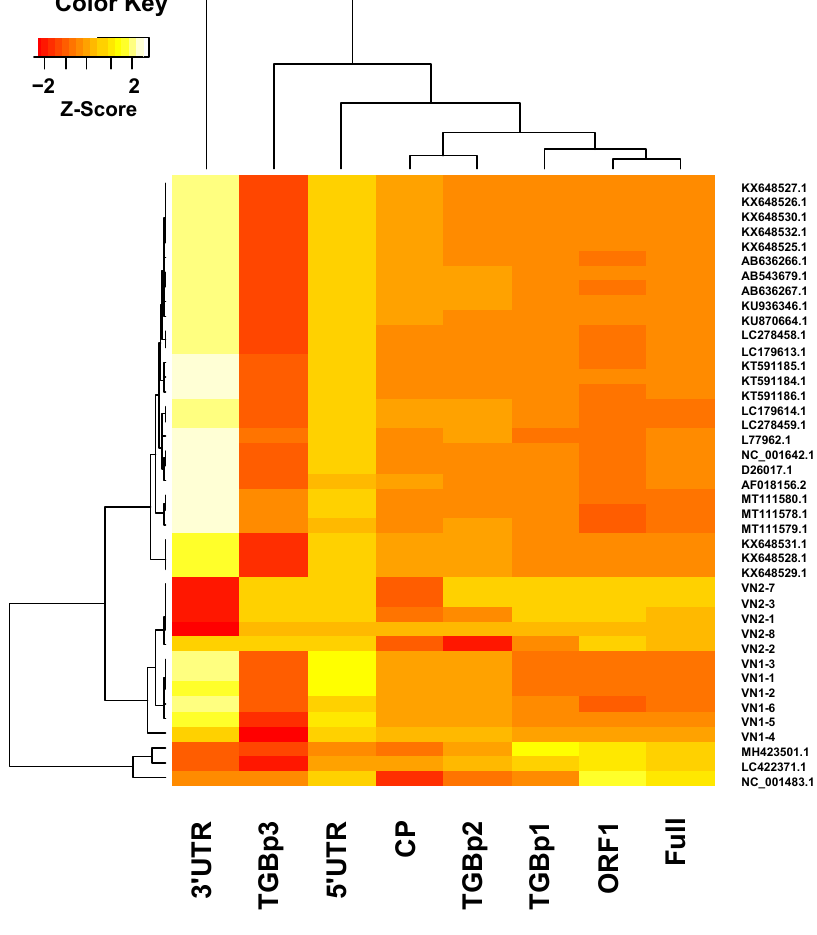
Figure 4. Heatmap representation of the similarities between different regions of BaMV-VN2-9 and the corresponding regions of other BaMV strains/isolates or closely related potexviruses. To identify the region in the BaMV genome that closely represents the divergence of BaMV genomes, different regions (as indicated at the bottom) of BaMV-VN2-9 were compared with the respective regions in other BaMV strains/isolates or closely related potexviruses. The sequence similarities were normal- ized to different regions of the BaMV genome as z-scores [33] and shown in the heatmap, with dif- ferent colors as indicated on the top-left. The dendrograms on the top and left of the heatmap illus- trate the hierarchical clustering based on the different regions or BaMV strains/isolates, respectively. To identify the mutational hotspots in the BaMV genome, the nucleotide polymor- phism and divergence were analyzed using the program DnaSP 6.0 [34], with a sliding window length and step size of 100 and 25 nucleotides, respectively, using default param- eters. The result of average nucleotide divergence analysis over the genome of all BaMV isolates revealed the presence of a highly polymorphic region near nucleotide positions (nts) 1200–1600 (Figure 5a) relative to the multiple sequence alignment. Further analysis of overall nucleotide divergence between BaMV-VN2 and other different subgroups (as shown in Figure 2) of BaMV isolates showed that the most divergent region between BaMV-VN2 isolates and other non-Vietnam subgroups of BaMV resides also approxi- mately at nts 1200–1600 region (Figure 5b). However, the most divergent region between BaMV-VN2 and BaMV-VN1 is located in the CP coding region (Figure 5b, light